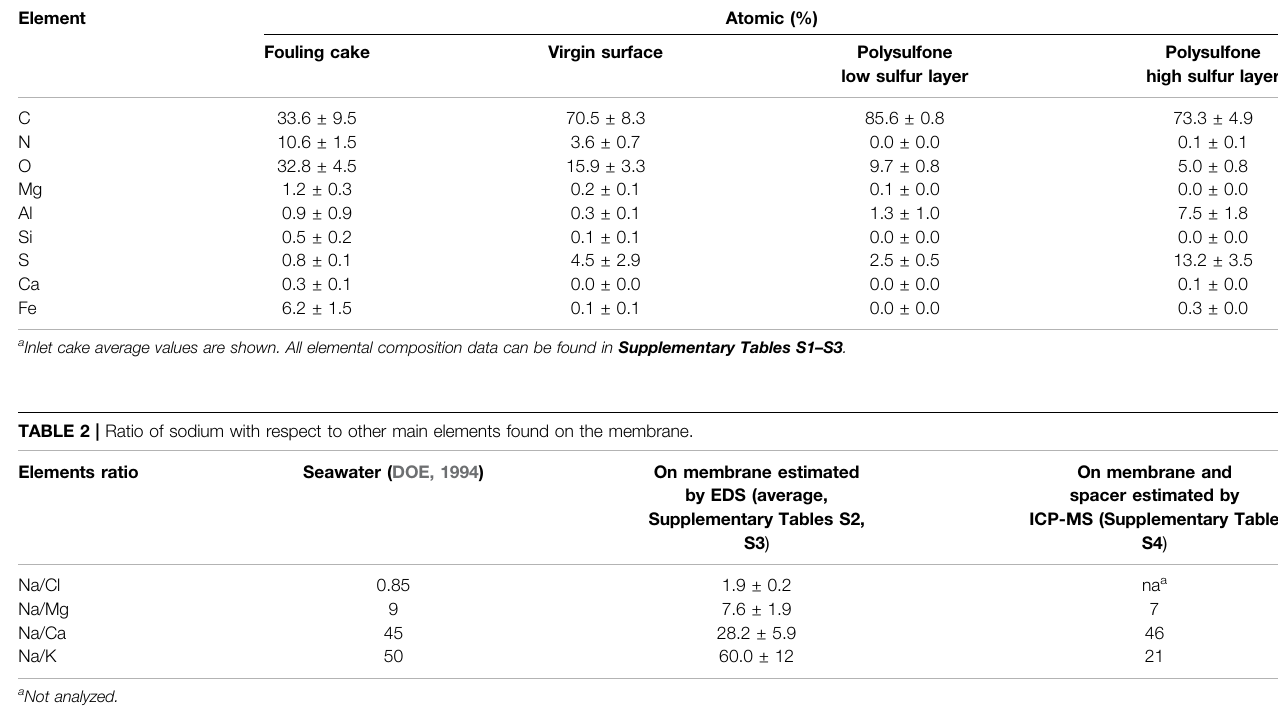
TABLE 1 | Elemental composition of the fouling material (cake a ) material of the RO membrane. For comparison, the composition of a clean virgin surface was measured. Moreover,theelementalcompositionofthetwodistinctpolysulfonelayersasshownin Figure6D revealstheircontrastingsulfurcontent.ThedatawasobtainedbyEDS analysis.